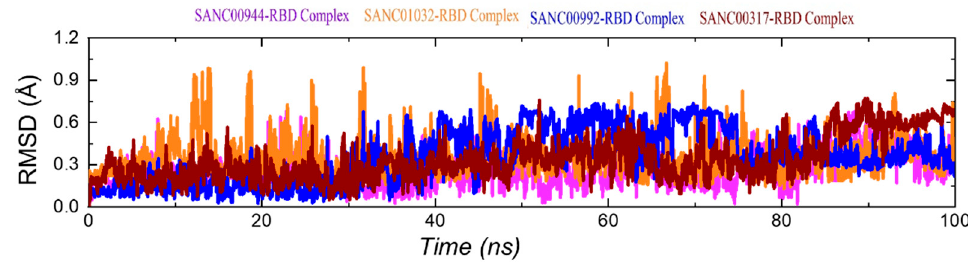
Figure 7. RMSDs of the bound ligands only during the simulation.